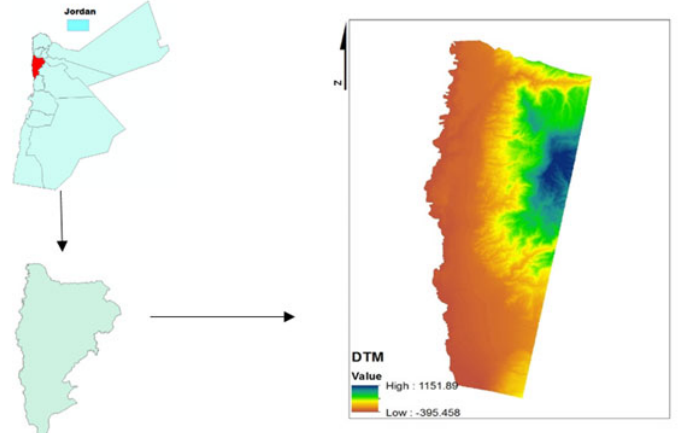
Fig. 1. Location map of the study